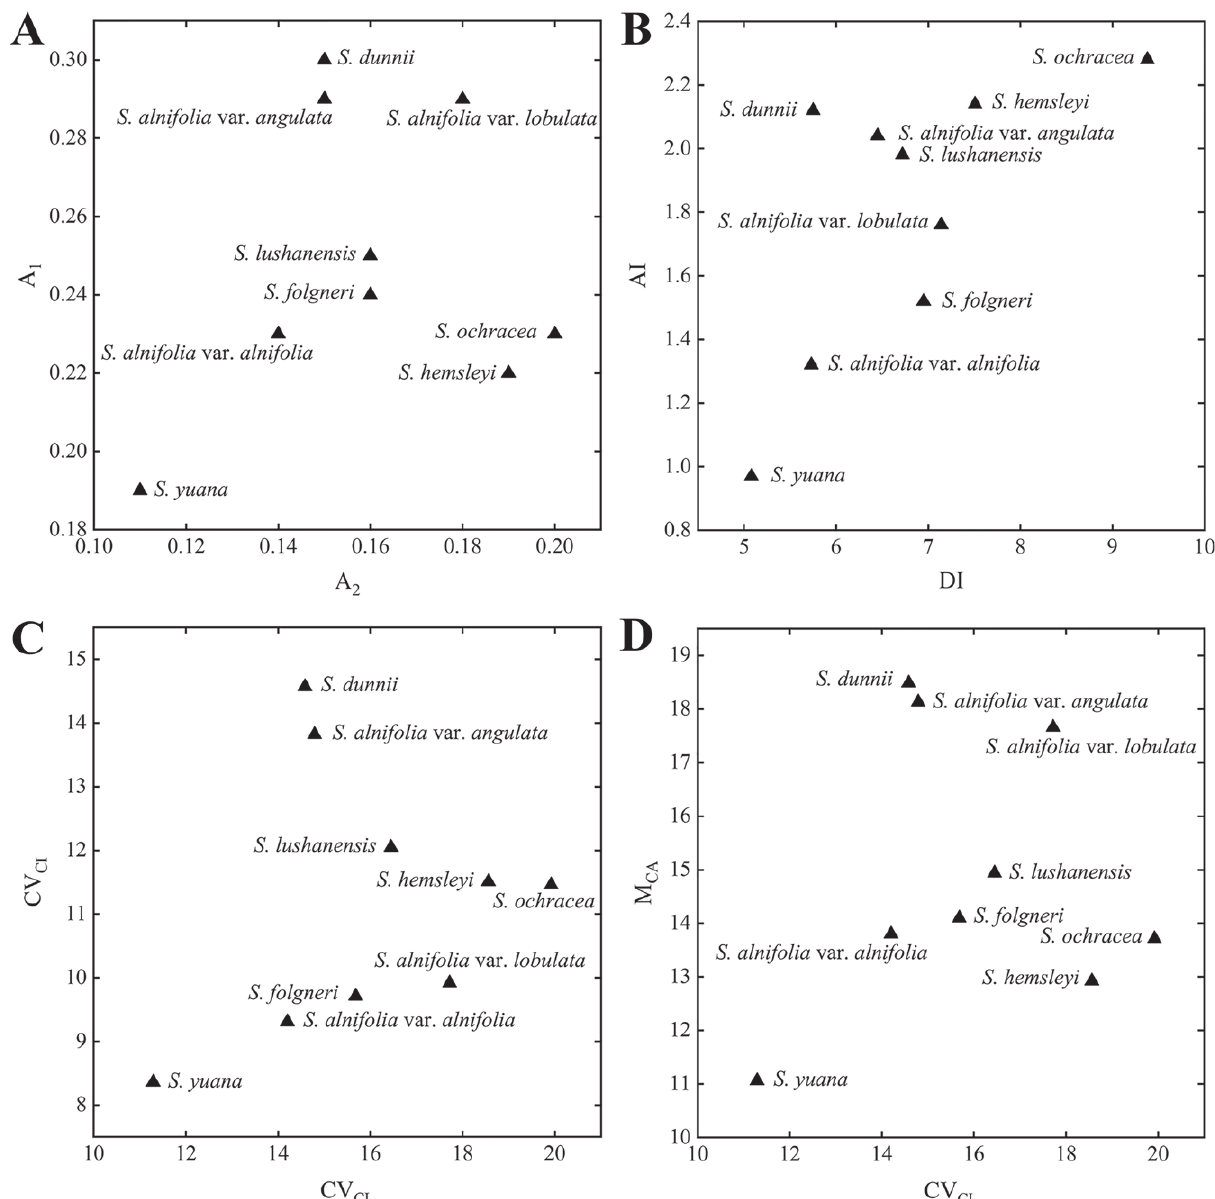
Figure 3. Scatter plots of studied taxa based on karyotype parameters. A- A1 versus A1; B- AI versus DI; C- CVCI versus CVCL; D- MCA versus